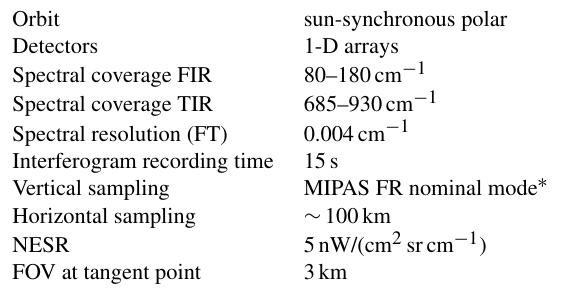
Table 1. Instrumental and observational parameters of